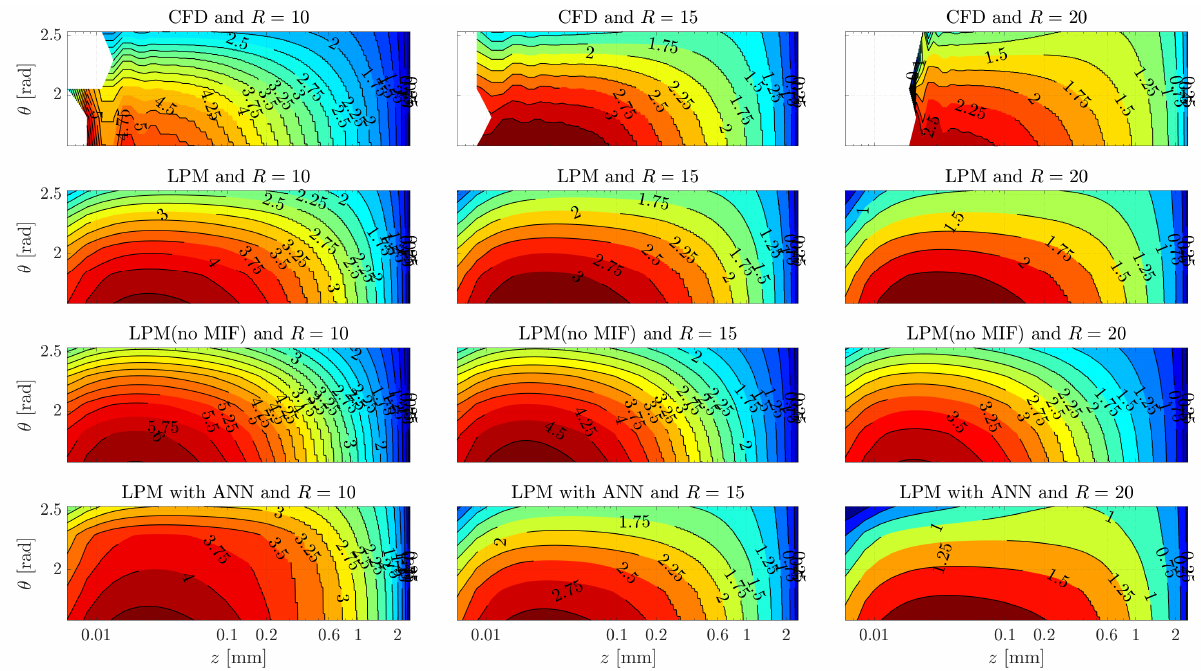
Figure 14: Simulation results of plunger movement with varying shaft angles ( θ ) (change of flow conditions) and three increments of plunger radius. Q = k θ sin( θ ) since this emulates the flow conditions of a rotating fluid power